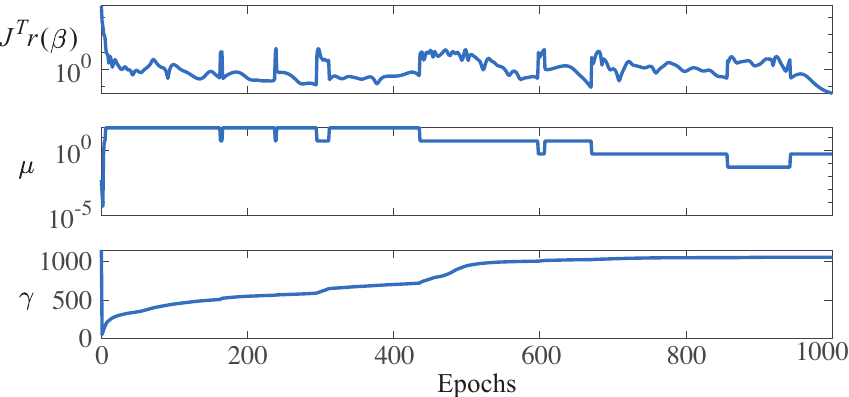
Figure 15. Values at each training epoch iteration for the gradient, J T r ( β ) , damping parameter, µ , and effective number of parameters, γ , for